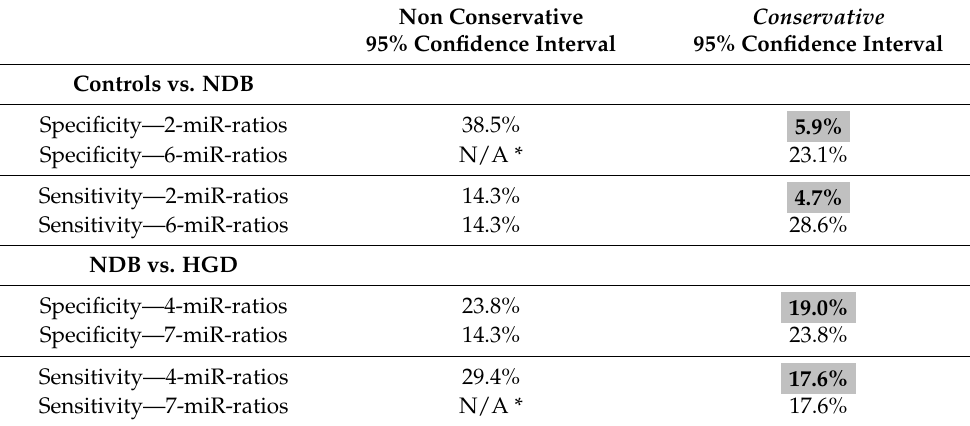
Table 1. Comparison of the effects of using the non-conservative prediction error variance estimator versus the conservative estimator on 95% confidence intervals for specificity and sensitivity of the conservatively derived models and the non-conservatively derived models. The smallest confidence intervals are highlighted with bold text on a grey